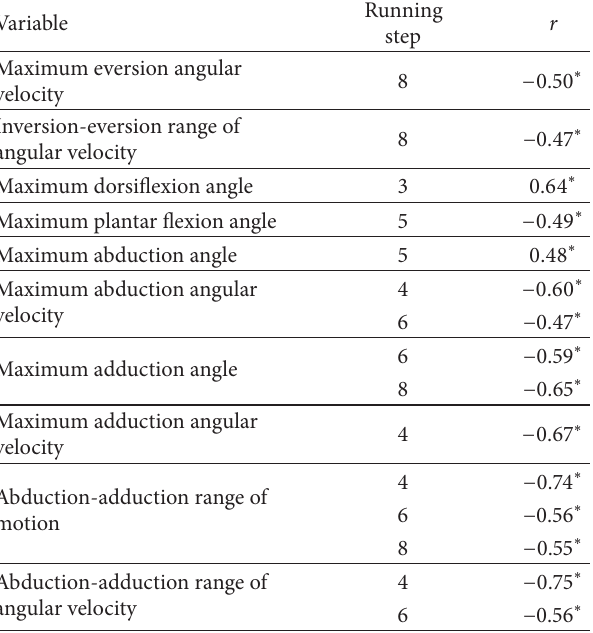
Table 2: Values of correlation coefficients ( r ) between running time over a 10-meter section and individual kinematic variables of the ankle